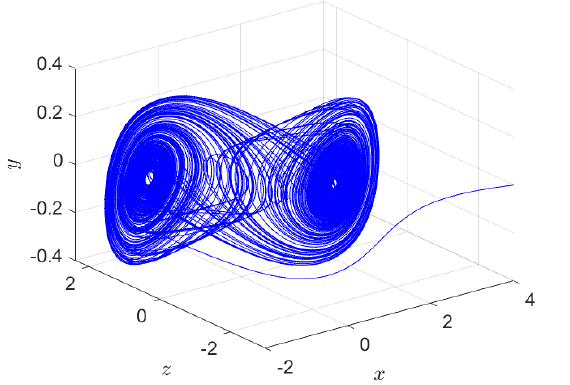
Figure 4. The chaotic phenomenon of system (58) with the initial condition X ( 0 ) = [ 4,0, − 3 ] T .